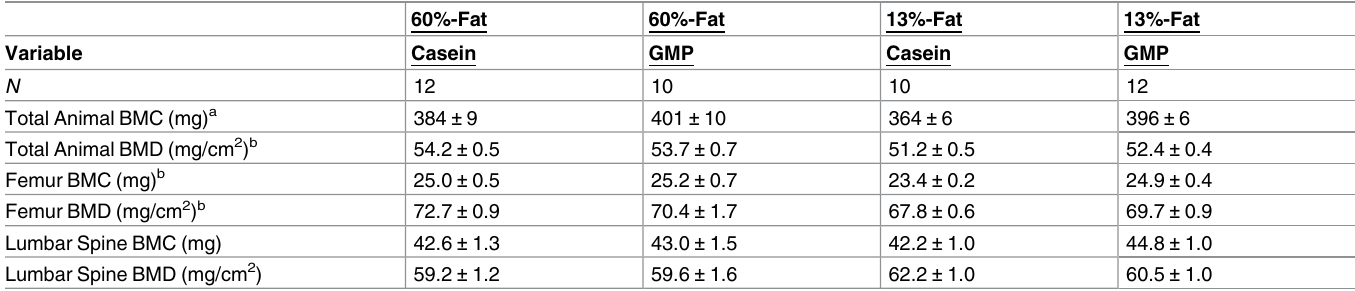
Table 2. In vivo DXA measurements.